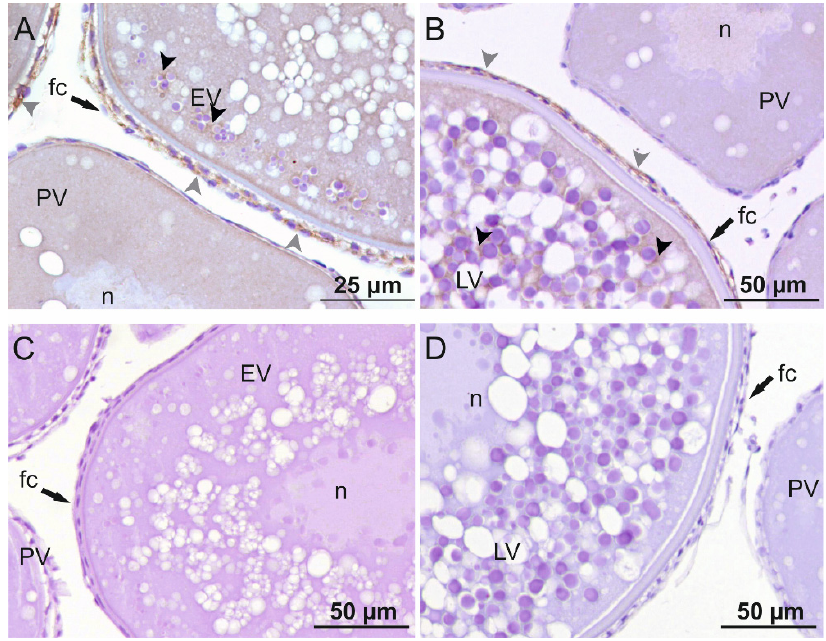
Figure 4. Immunolocalization of Amh in sea bass ovaries at different developmental stages. Photo- micrographs of ( A ) early vitellogenic (EV) and ( B ) late-vitellogenic (LV) follicles showing Amh staining signal in follicular cells (gray arrowheads) and the cytoplasm (black arrowheads); ( A , B ) The signal is absent in previtellogenic follicles (PV); ( C ) Control sections of early vitellogenic and ( D ) late-vitellogenic follicles without primary antibody. n: nucleus; fc: follicular cell.